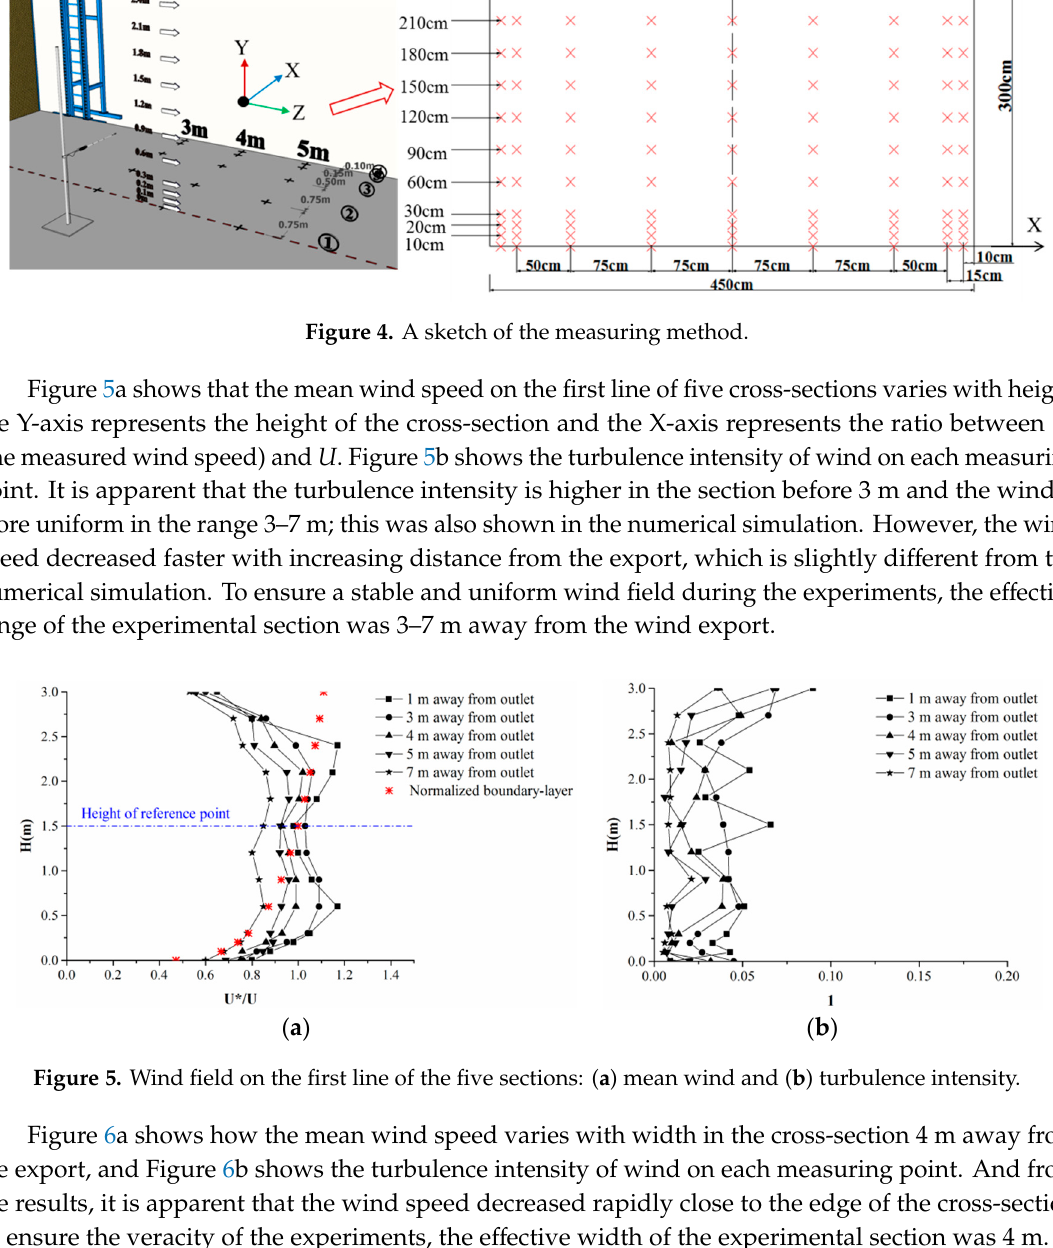
Figure 5. Wind field on the first line of the five sections: ( a ) mean wind and ( b ) turbulence intensity.